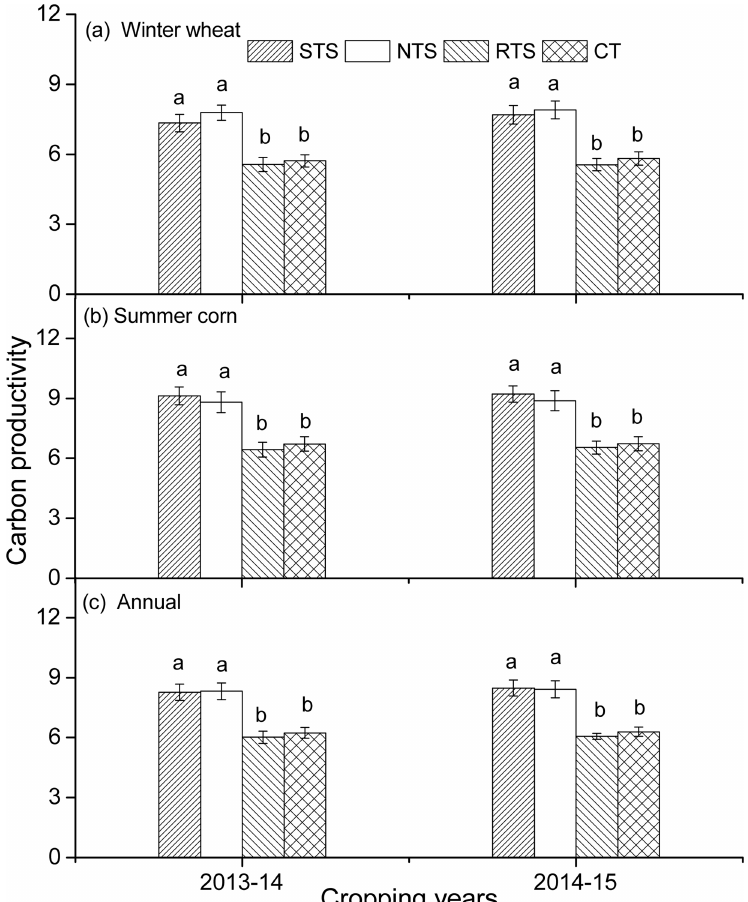
Fig 4. Effect of different tillage treatments on carbon productivity of winter wheat (a), summer corn (b), and annual (c) in both cropping years. (The different lowercase letters above the error bars represent significant difference between different tillage treatments within a two-year period at 5% levels according to the LSD test. CT: conventional moldboard plowing tillage without crop straw; RTS: rotary tillage with straw incorporation; STS: chisel plow tillage with straw incorporation; NTS: no tillage with straw